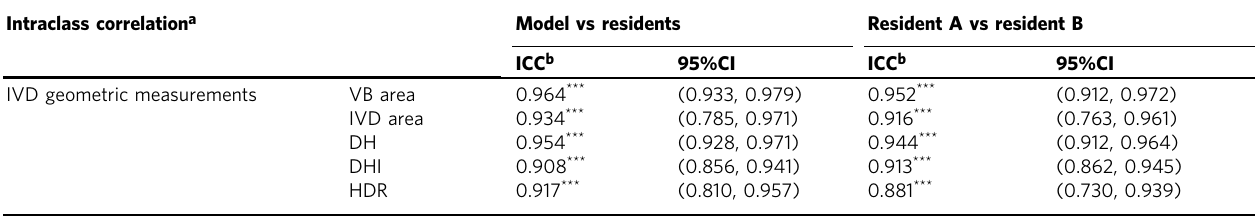
Table 2 Consistency analysis of IVD parameters measurements between model and